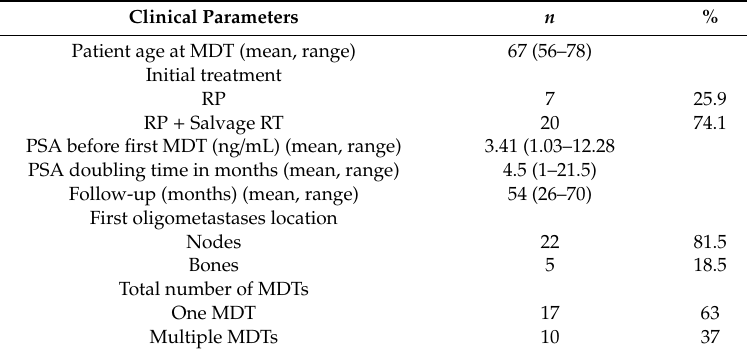
Table 1. Clinical data of 27 oligometastatic prostate adenocarcinomas.